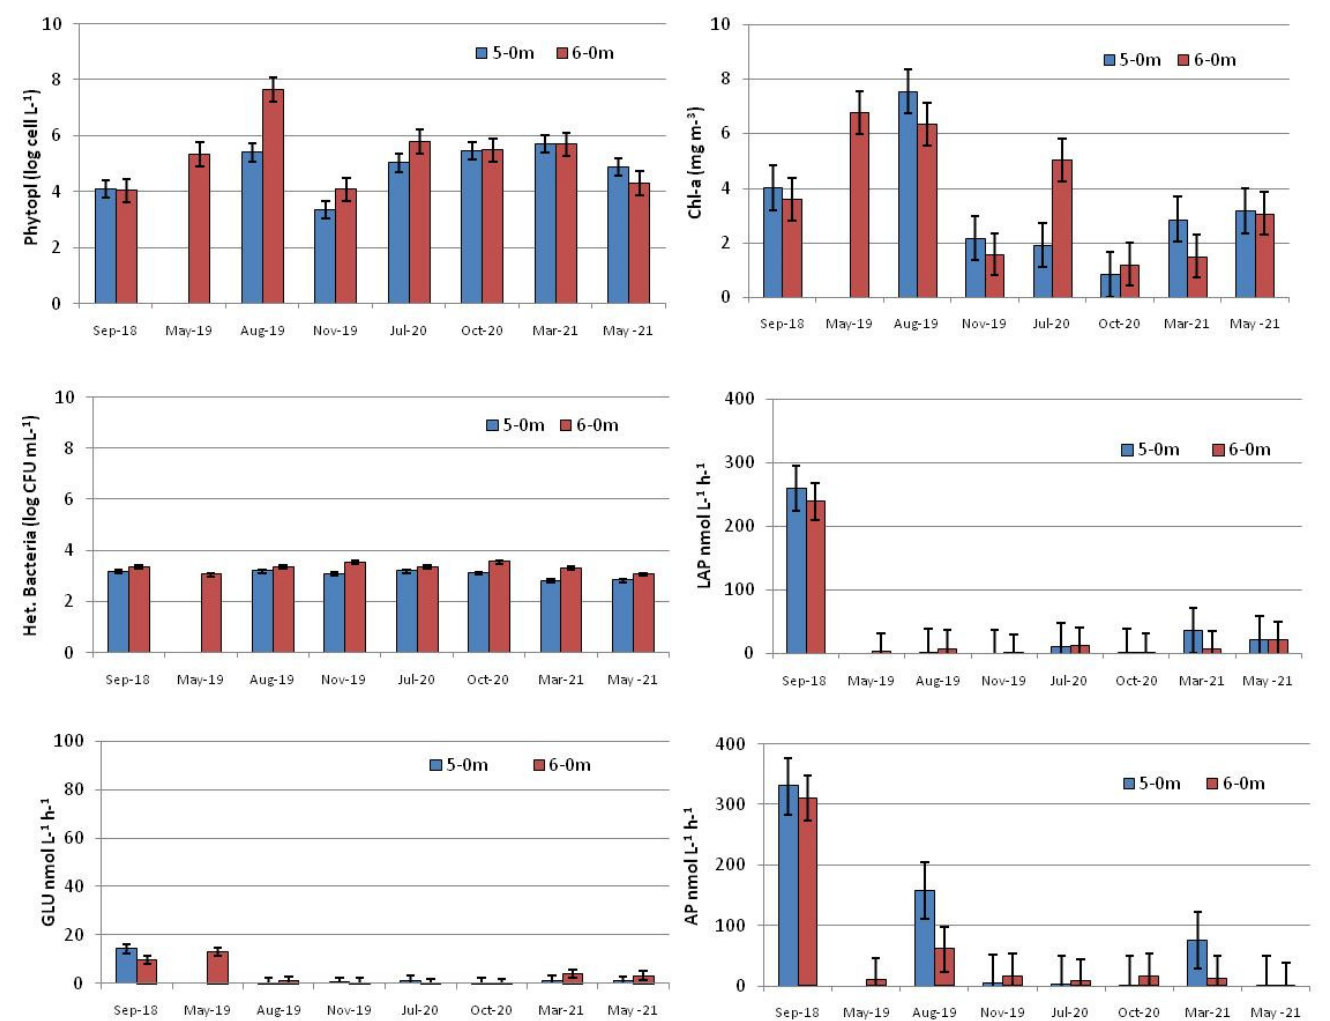
Figure 5. Seasonal trends of autotrophic abundance and biomass (as Chl a content) and heterotrophic bacterial abundance, together with microbial activity rates, observed at the control stations.